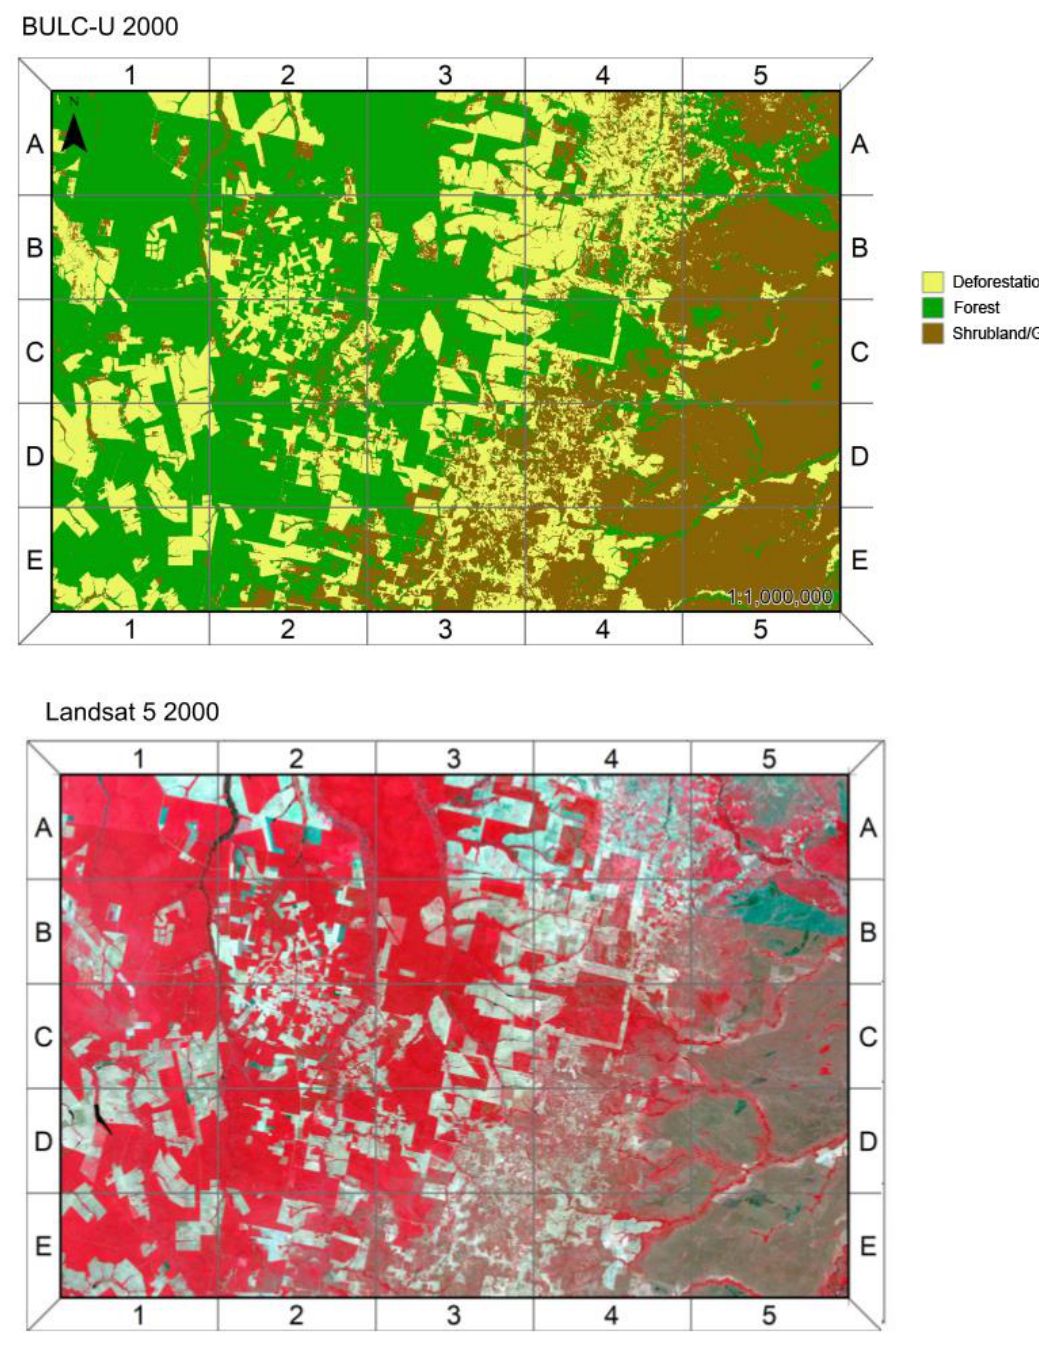
Figure 5. LULC at end of study period. BULC-U 2000 Classification (above) and raw Landsat 5 image of 2000 (below).